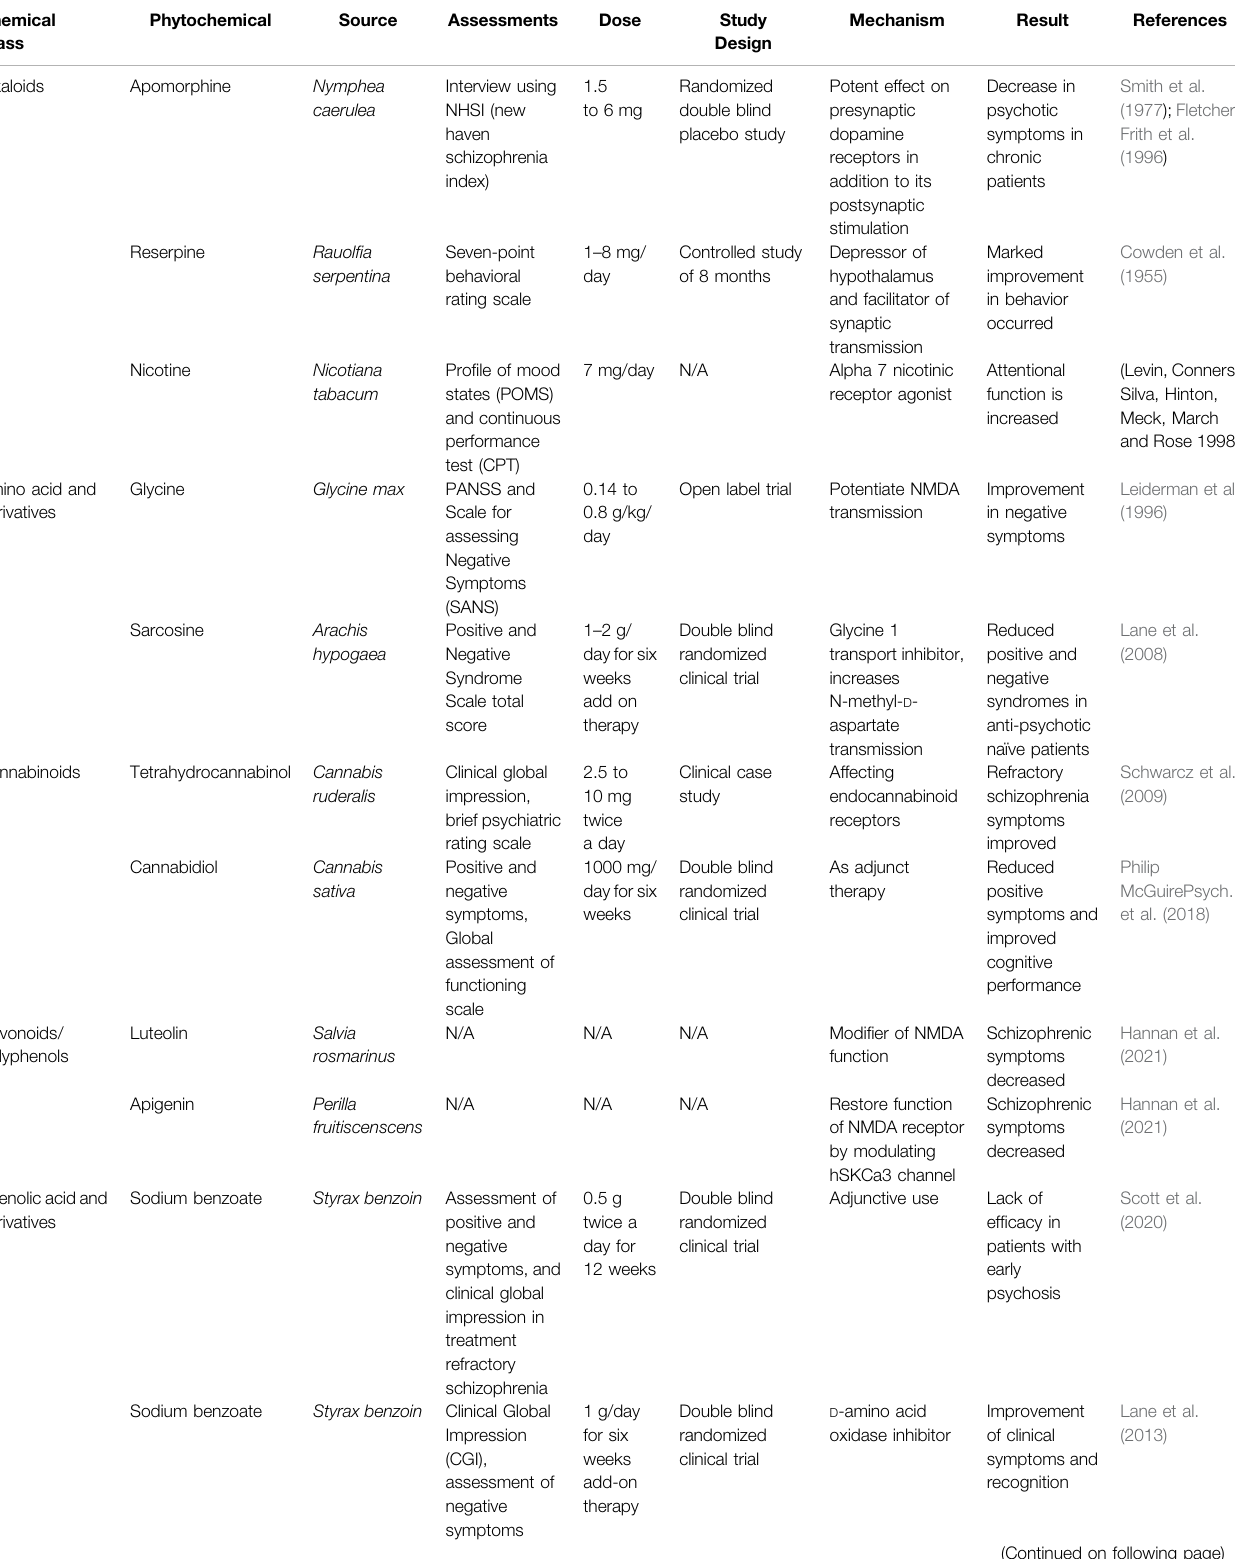
TABLE 2 | Antipsychotic potential of phytochemicals in clinical